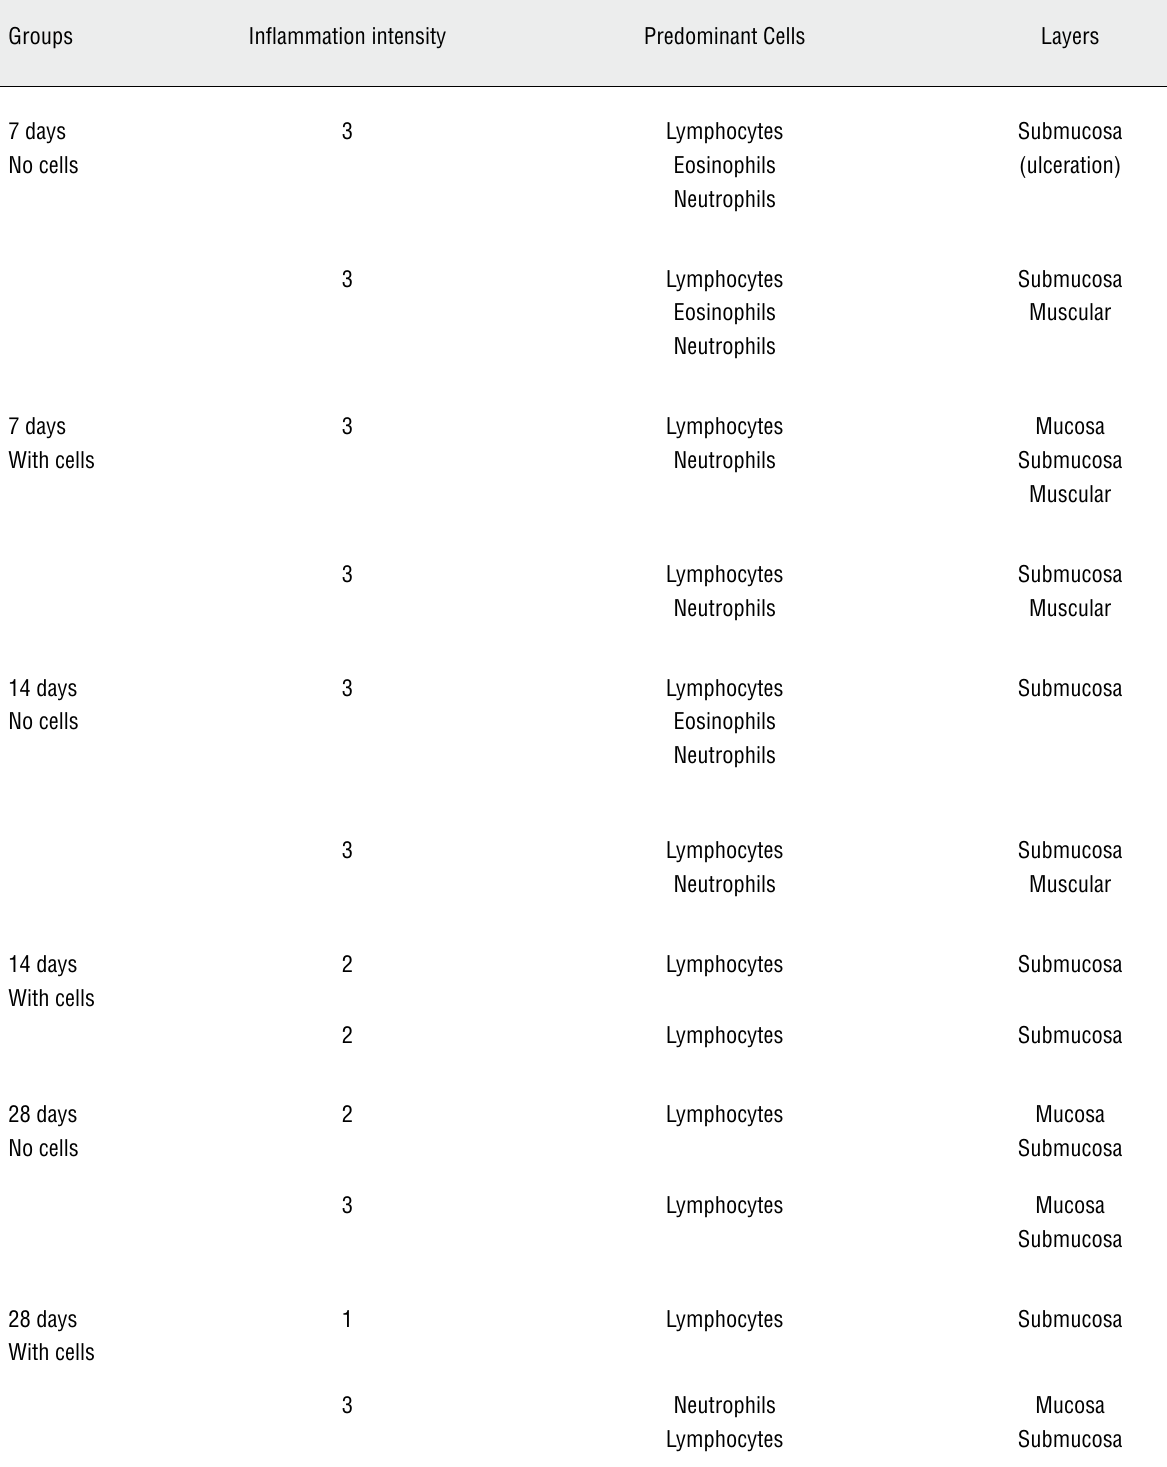
Table 1 - Anatomopathologic findings.